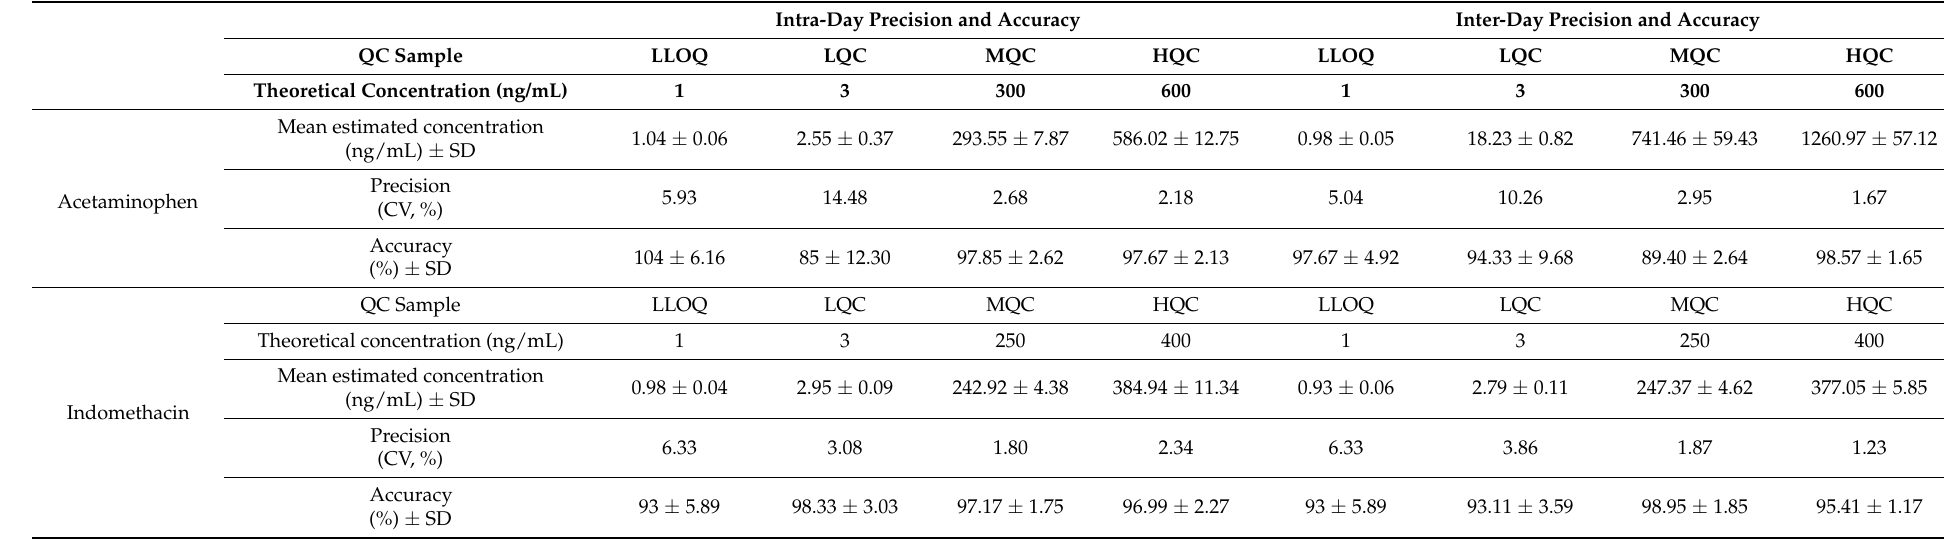
Table 1. Determination ( n = 6) of Intra-and inter-day precision and accuracy.